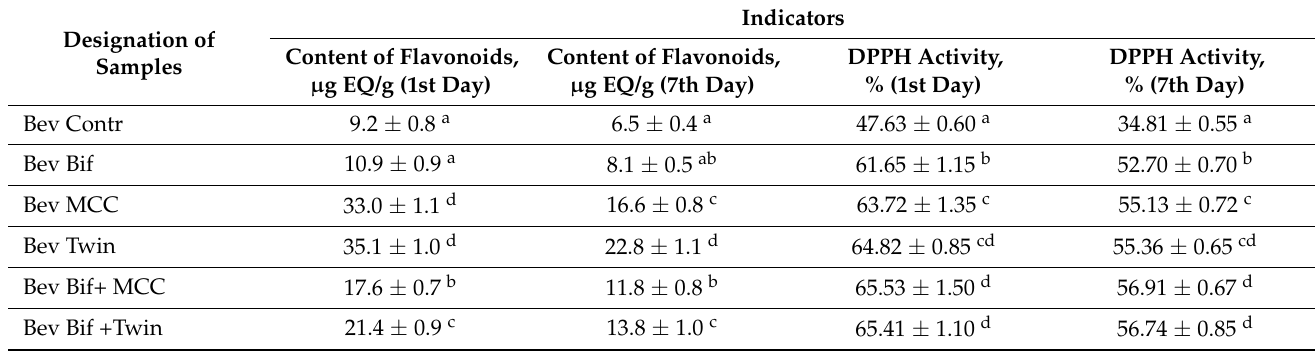
Table 3. Antioxidant activity and flavonoid content in plant-based beverages stabilized with ME.